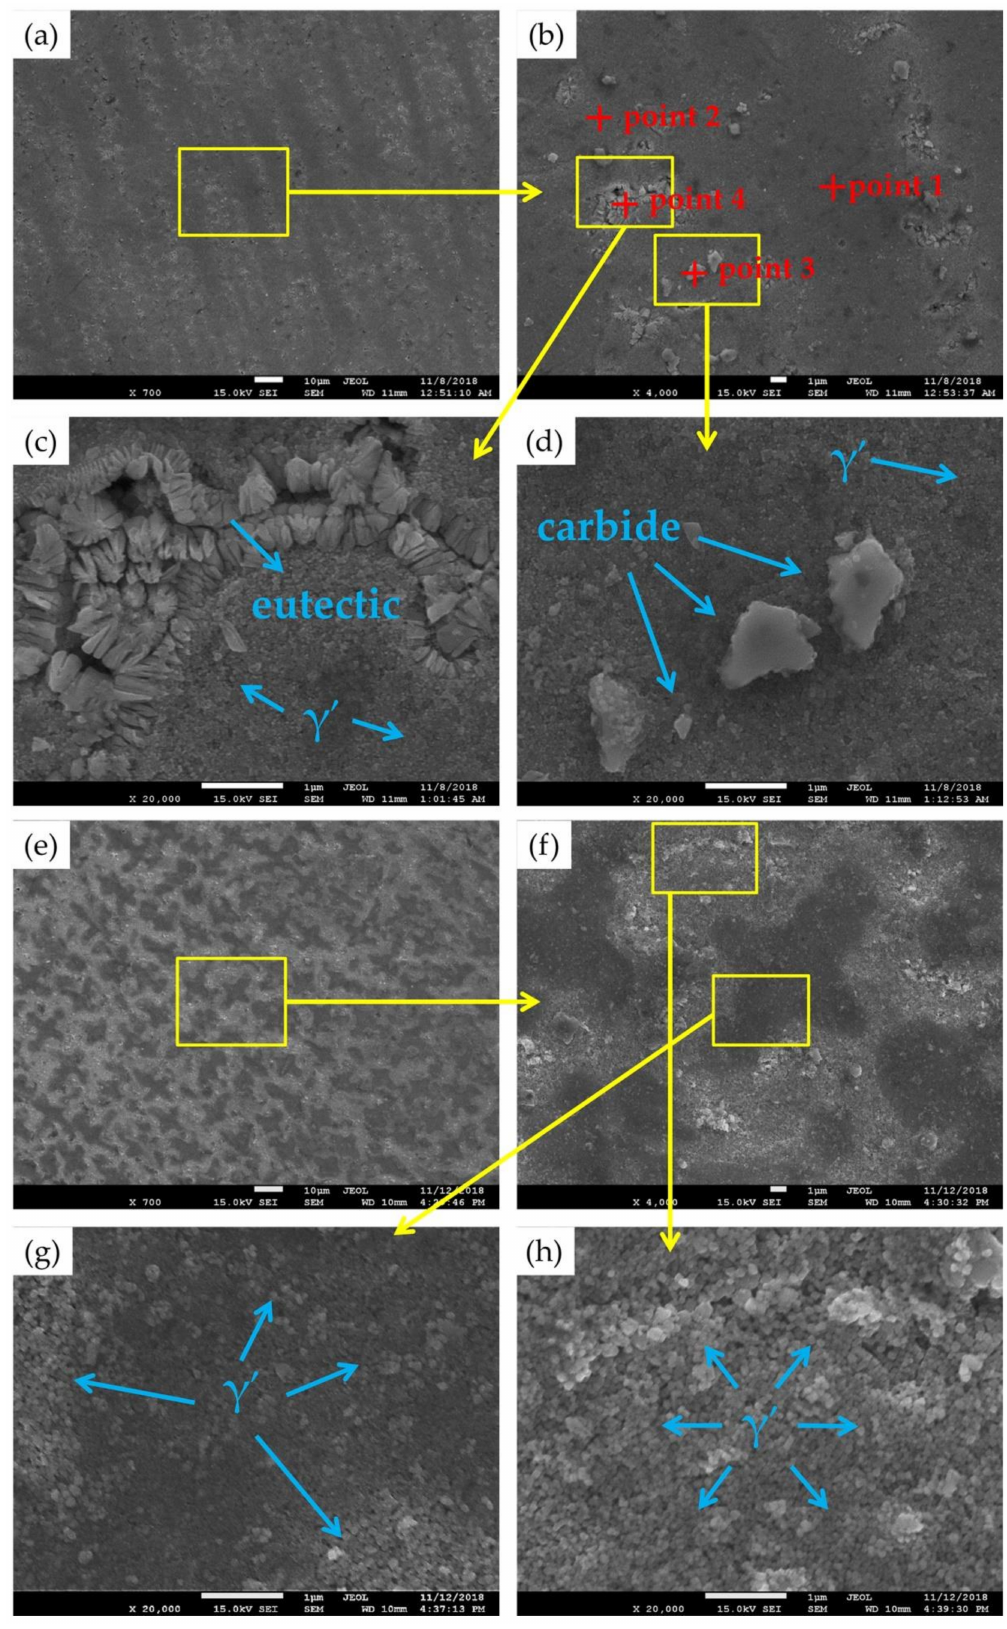
Figure 4. Typical microstructure on ( a – d ) the X–Z section and ( e – h ) the X–Y section of the as-deposited